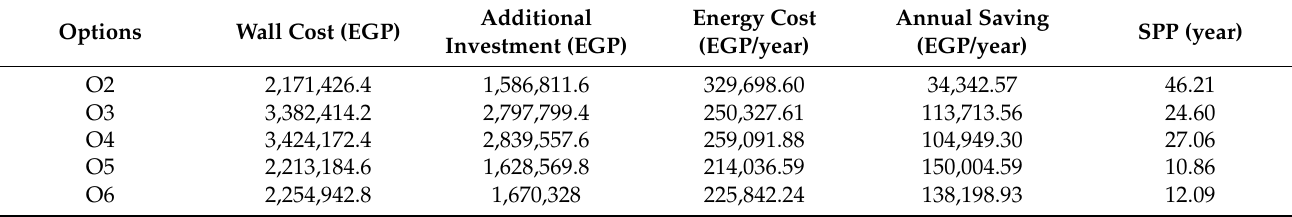
Table 4. Summary of the cost–benefit analyses